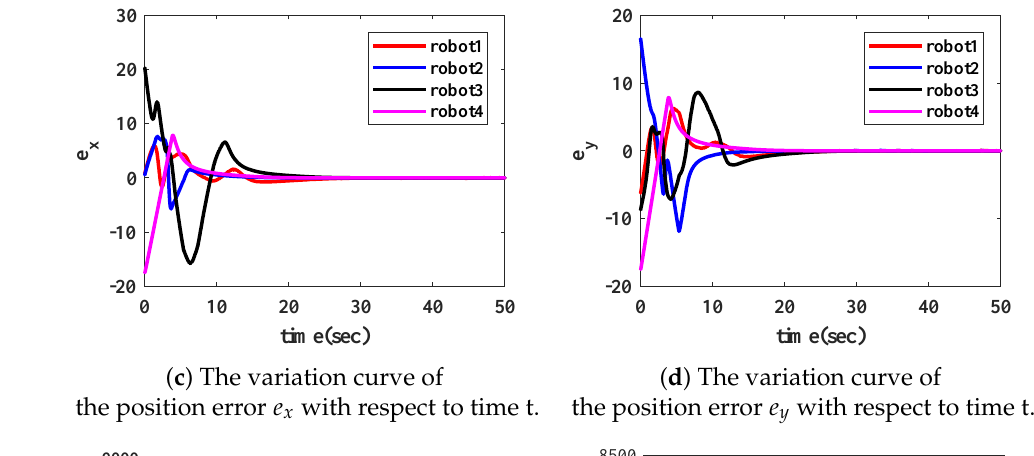
( d ) The variation curve of the position error e y with respect to time t.